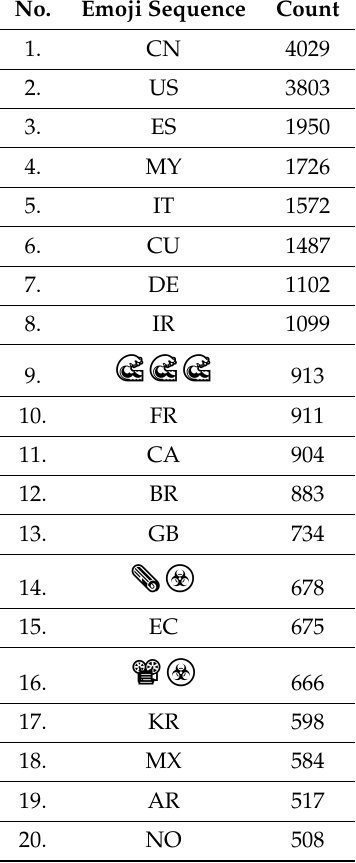
Table 3. The main categories and subcategories of bots’ memes.